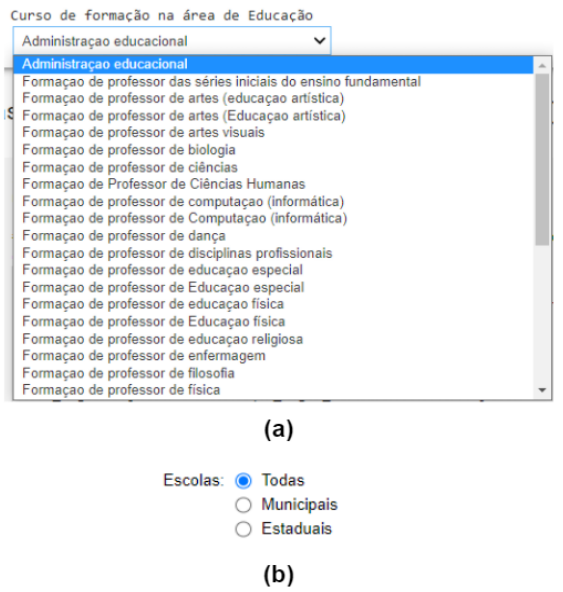
Figure 2 . (a) Widget of higher education course . (b) Widget of options of aggregation of the percentage of graduate professors.